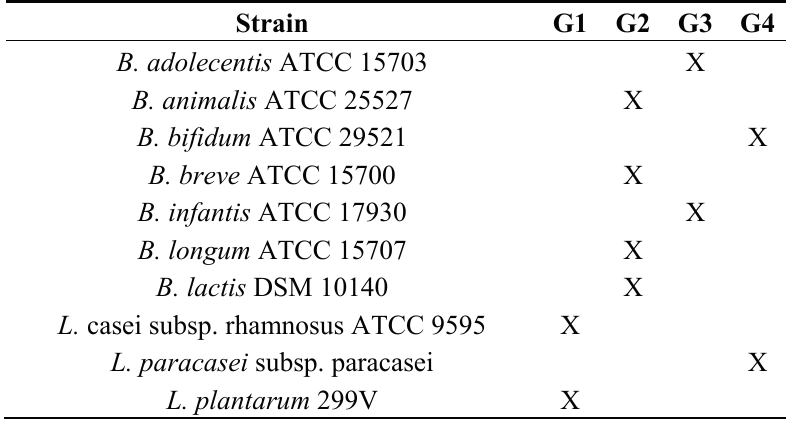
Table 2. Bifidobacterium and Lactobacillus strains clustered in four groups (G), with different patterns of growth.